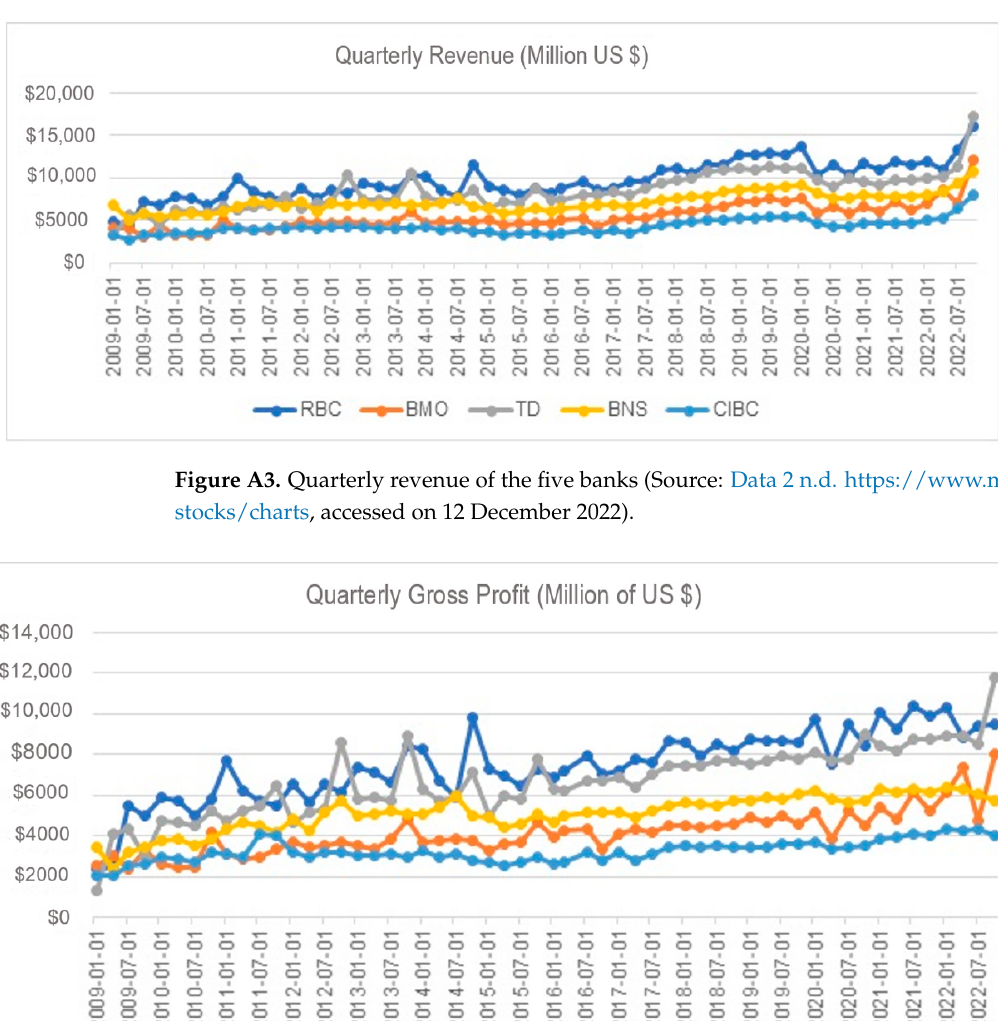
Figure A2. Quarterly total assets of the five banks (Source: Data 2 n.d. https://www.macrotrends.net/stocks/charts, accessed on 12 December 2022).